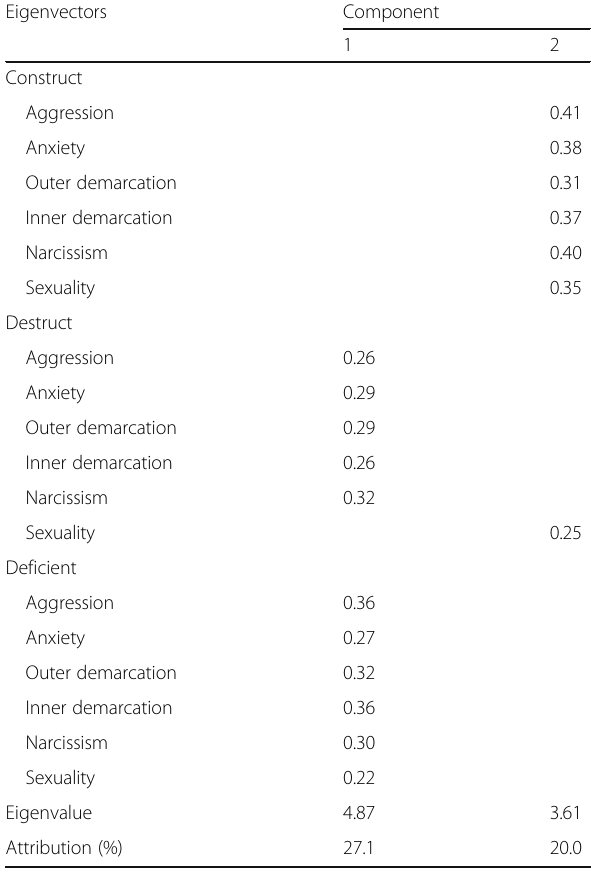
Table 2 Principal component analysis of ISTA scores